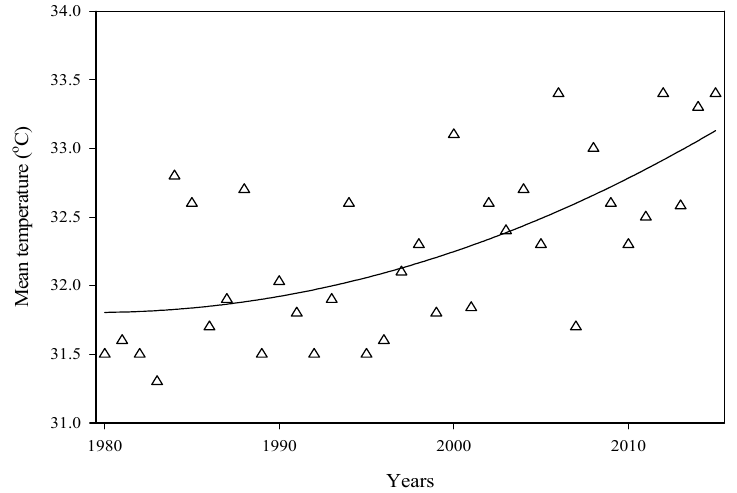
Figure 1. Mean total temperature during the cotton growing season from 1980 to 2015 at 15 sites in Punjab, Pakistan.